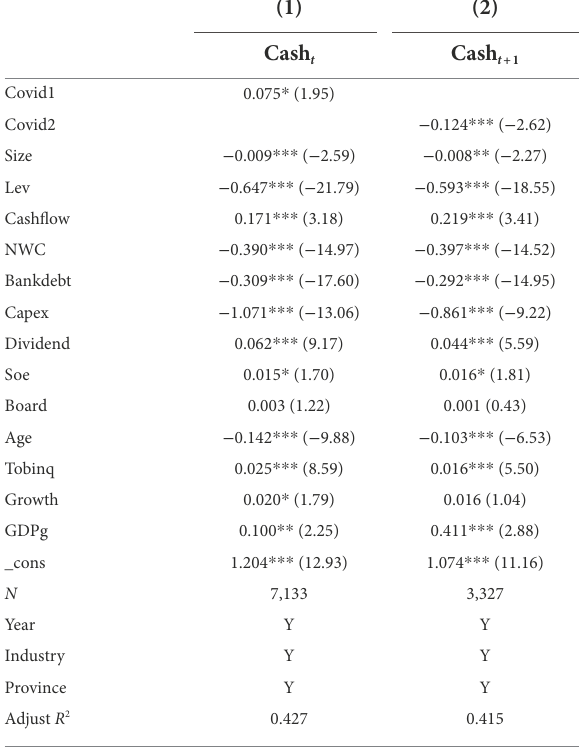
TABLE 2 COVID-19 impact and corporate cash